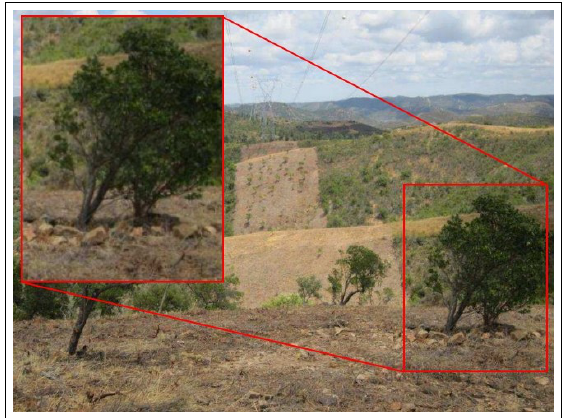
Figure 1. Typical firebreak strip with slopes, rocky soil and protected trees such as Arbutus Unedo (highlighted on the top left corner). Image courtesy of REN (Portuguese National Power